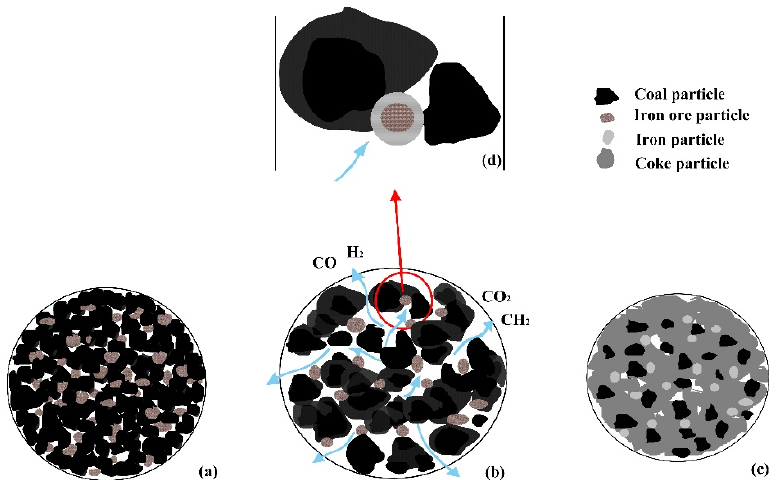
Figure 9. Conceptualdiagram of the synergistic effect between iron ore and coal: ( a ) before pyrolysis; ( b ) the primary pyrolysis stage; ( c ) the secondary pyrolysis; ( d ) the reduction of iron ore particles.